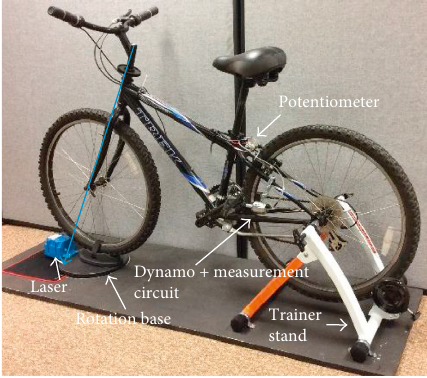
Figure 1: ZouSim hardware